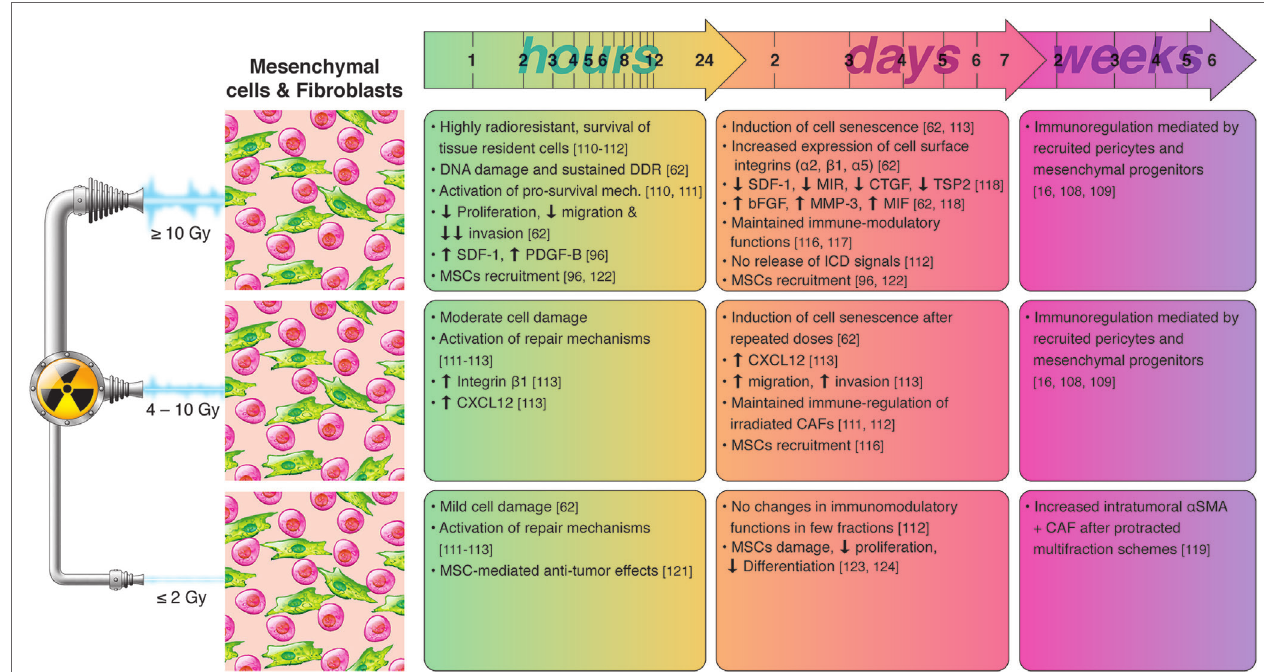
FiGURe 3 | Chronological effects observed on cancer-associated fibroblasts (CAFs) and mesenchymal cells after RT delivered at different dose per fraction. The figure is a compilation of observations registered in different experimental models, comprising primary cell cultures (in vitro), cell lines, animal (mainly mice) models, and clinical observations, on effects of RT given at different dose/fraction . Studies on RT effects on CAFs are scarce. It is well demonstrated that tumor fibroblasts are quite radioresistant and may survive even ablative doses of radiation. Small doses may not change importantly the phenotype and functions of CAFs. At high doses, CAFs become senescent within few days post-irradiation, less motile, and less proliferative. High RT doses may substantially alter the secretory profile of CAFs characterized by reduced levels of SDF-1, MIR, or connective tissue growth factor (CTGF), and increased levels of bFGF, MMP3, or macrophage inhibitory factor (MIF), observed within few days post-RT. Of relevance, in vitro observations reveal that the immunosuppressive functions of cultured CAFs are preserved after exposure to high and low RT doses. In a long run, mesenchymal progenitors and pericytes recruited after medium and high doses may contribute importantly to immunoregulations, to prevent the onset of autoimmune